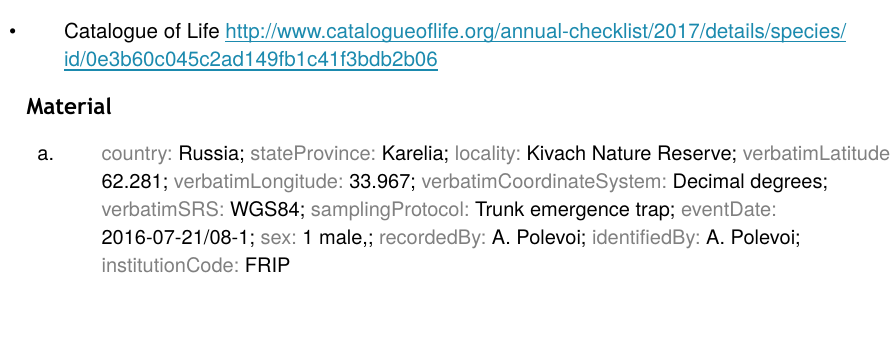
Distribution Europe. Known by a few records from the European part of Russia, Ukraine and Slovakia (Humala and Polevoi 2009, Jakovlev and Polevoi 1997, Martinovský and Rohá č ek 1993). Ecology Poorly known. Larvae were collected from spruce wood (Mamaev and Krivosheina 1966) and adults found sitting on very damp fi r logs (Martinovský and Rohá č ek 1993). According to Krivosheina (1991), larvae of Axymyiidae may colonise newly fallen trunks and stay there for several years. This species was collected from a wind-broken aspen, colonised by 7 species of macrofungi Table 1.